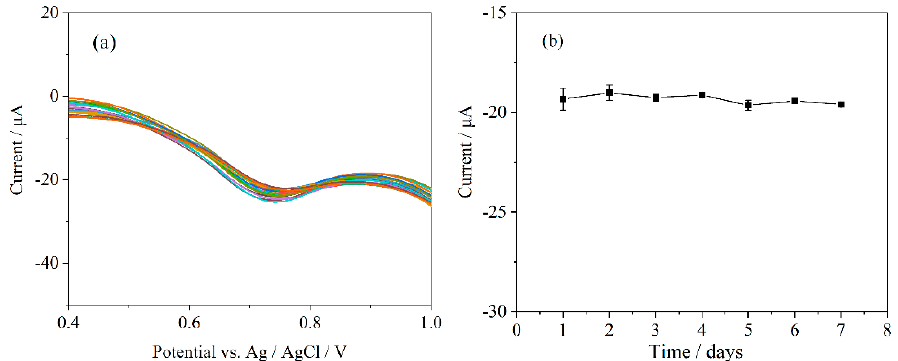
Figure 6. Twenty scans performed for the SWV measurements ( a ). Current response to FA after the sensor was left for a long time ( b ). The concentration of FA was 10 μ M. Error bars represent the standard deviations for three measurements.